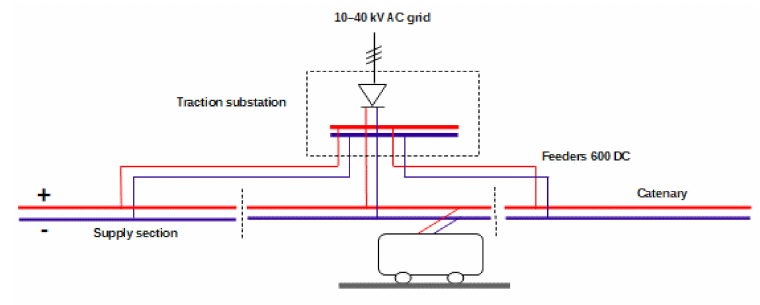
Figure 1. General scheme of trolleybus power supply system.